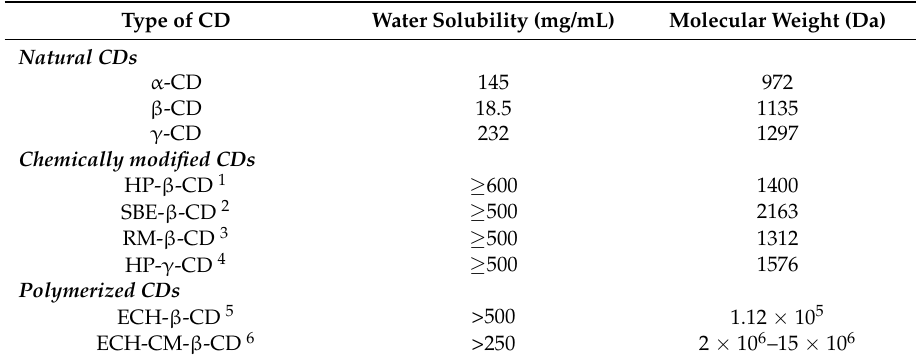
Table 3. Overview of natural and derived cyclodextrins (CDs).